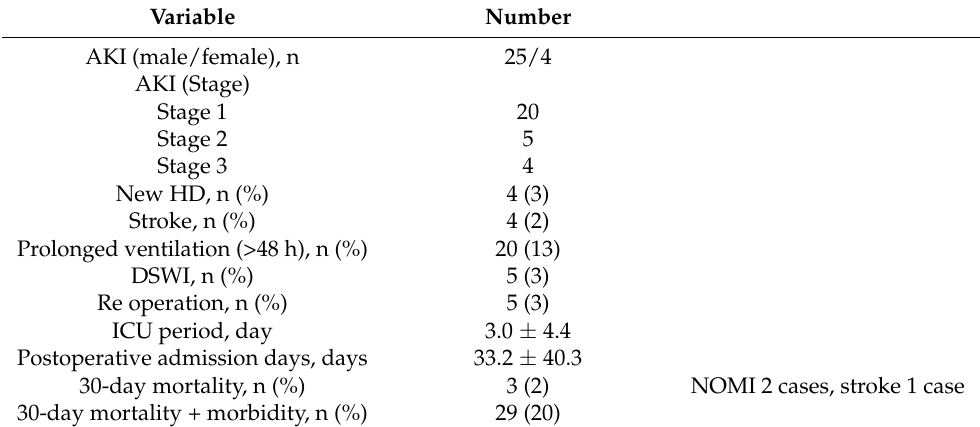
Table 2. Perioperative and postoperative complications.